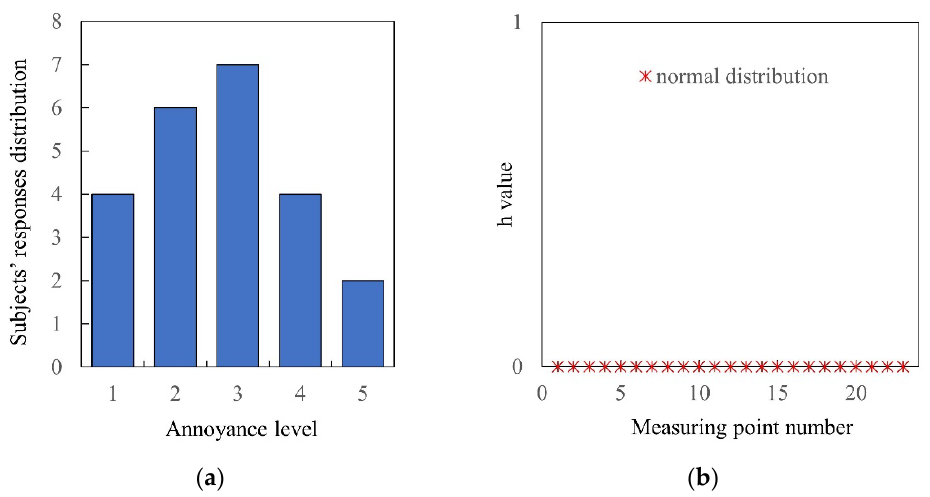
Figure 13. Normality test: ( a ) Subjective responses’ distribution of point 11; ( b ) Hypothesis test results of each measuring point.